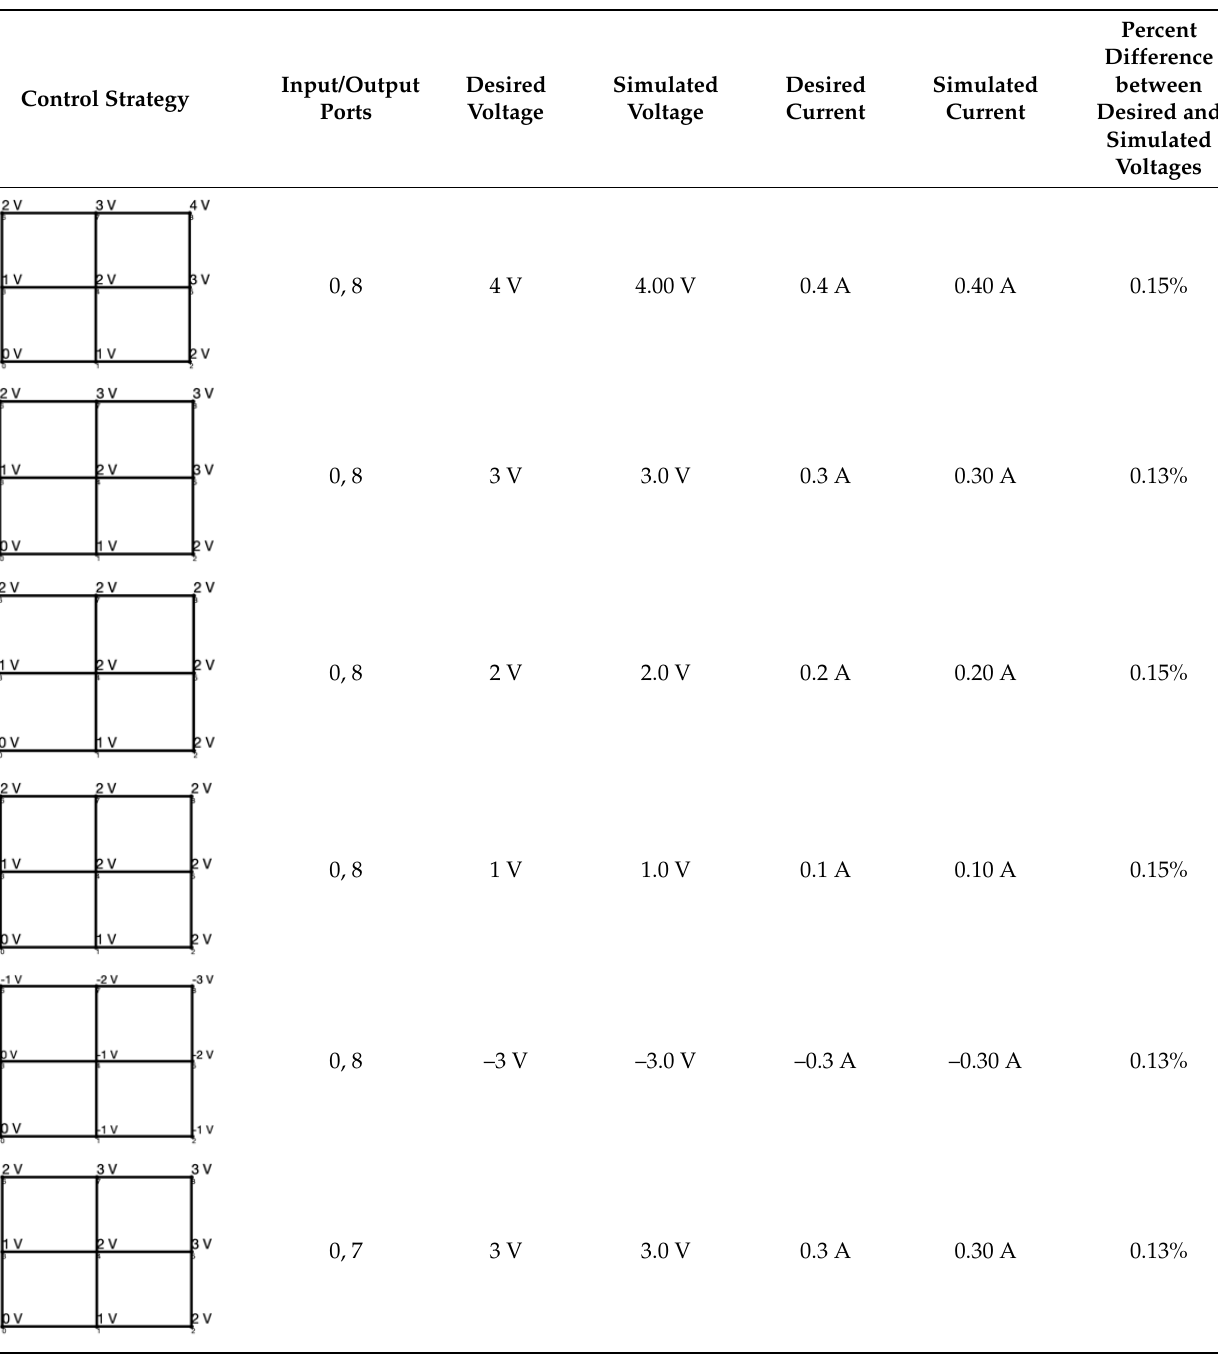
Table 3. Comparison between desired and simulated output voltages and currents. Load resistance is 10 Ω , internal resistances are 0.01 Ω for all edges.